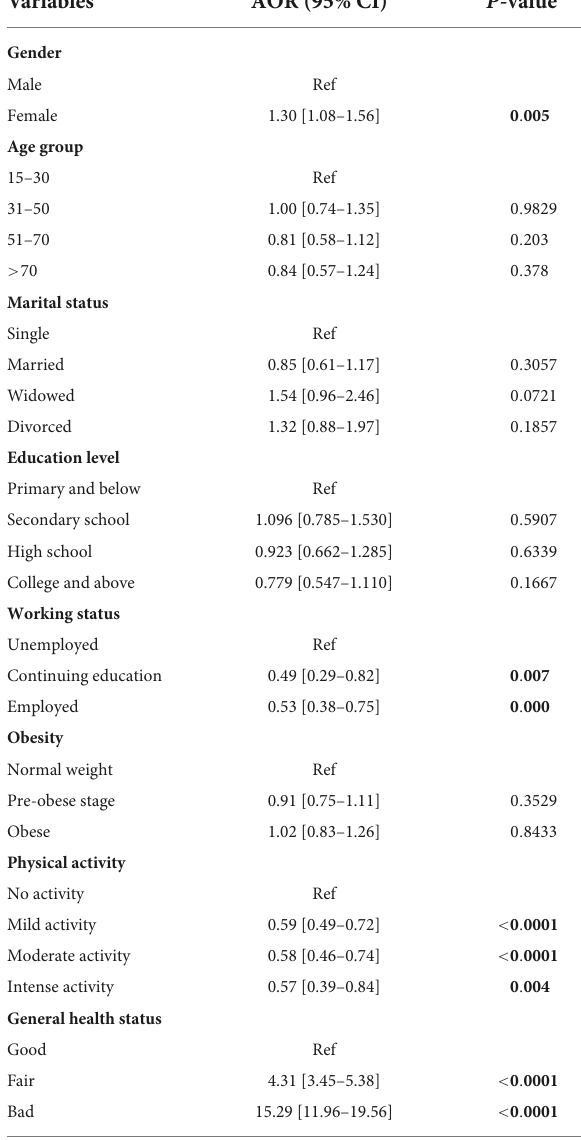
TABLE 3 Multivariate regression model for individual level